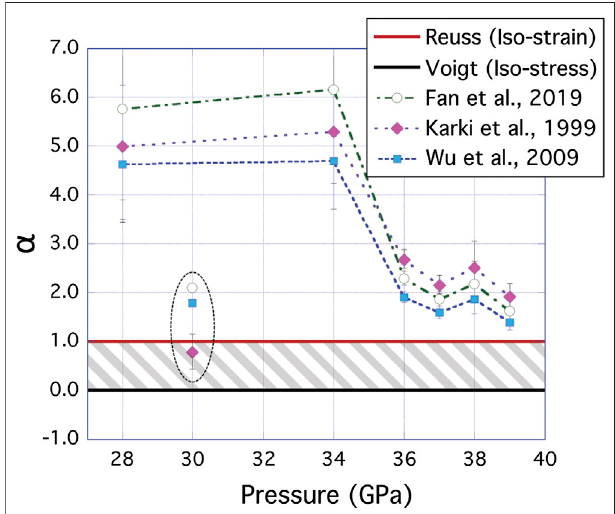
FIGURE 7 | Results of fi ts for the Voigt-Reuss weight parameter, α , for ferropericlase as determined for three different sets of single crystal elastic constants (Karki et al., 1999; Wu et al., 2009; Fan et al., 2019). Voigt and Reuss bounds (0 ≤ α ≤ 1) are shown as a solid black and a solid red line, respectively,withtheelasticregimeindicatedbygrayhatching.Barsrepresent the range of uncertainty in α based on the standard deviations in Q ( hkl ) from the Rietveld fi t. Values of alpha for the post-conversion pattern 001 (30 GPa, 300 K) are encircled by a black, dashed elliptic contour and shown for comparison with successive resistive heating